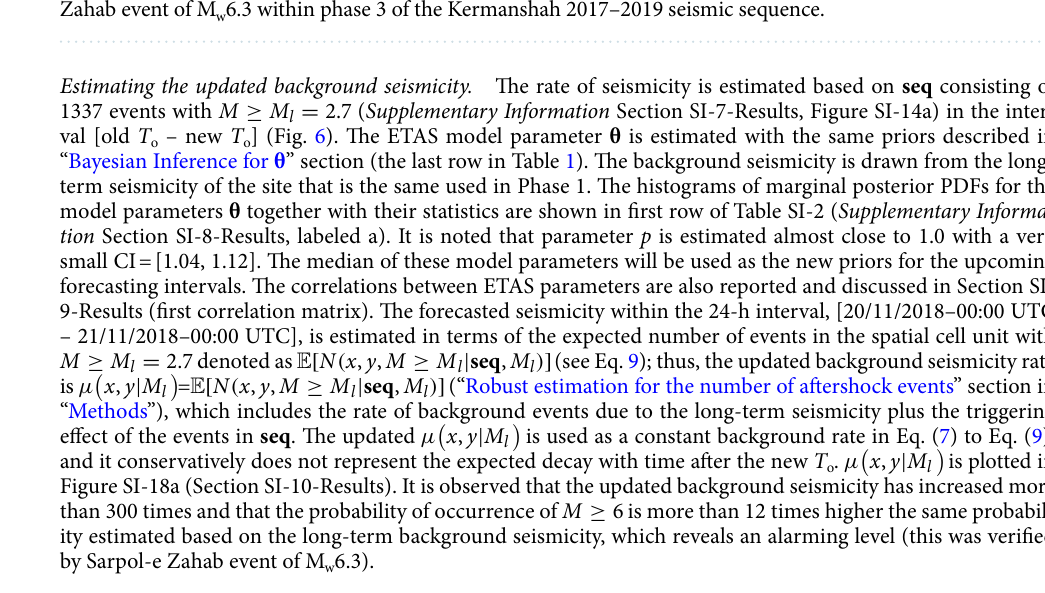
Figure SI-18a (Section SI-10-Results). It is observed that the updated background seismicity has increased more